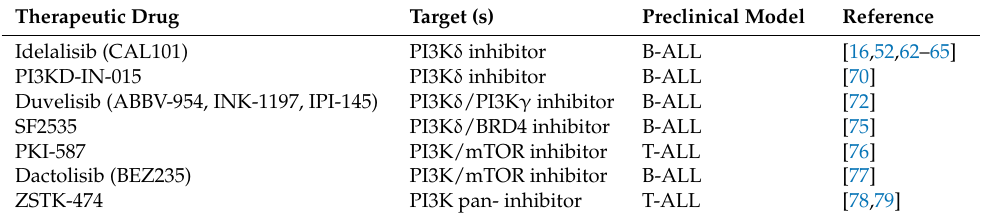
Table 1. PI3K inhibitors preclinically evaluated in acute lymphoblastic leukemia